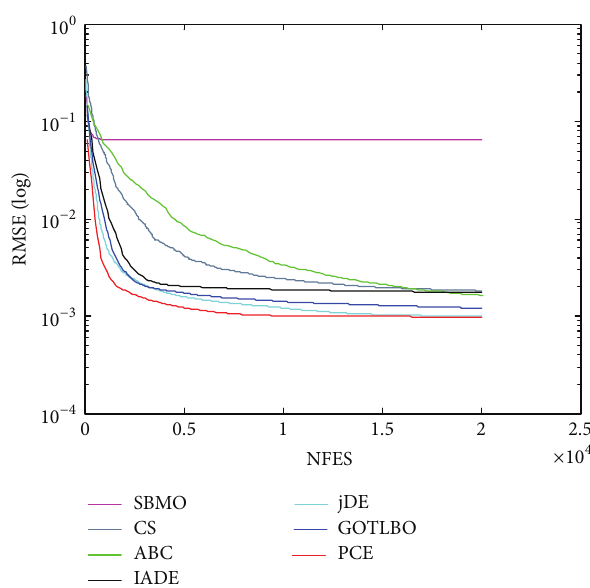
Figure 4: The convergence graph of different EAs for the double diode